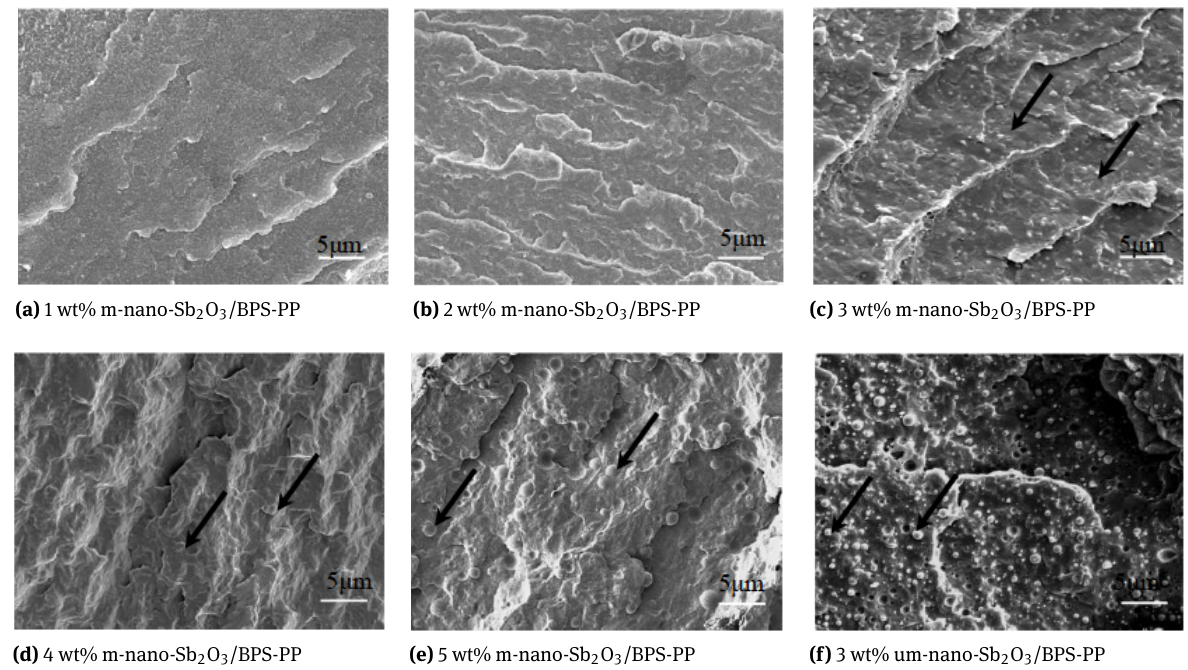
Figure 6: Impact fracture SEM images of the experimental nano-Sb 2 O 3 /BPS-PP composites